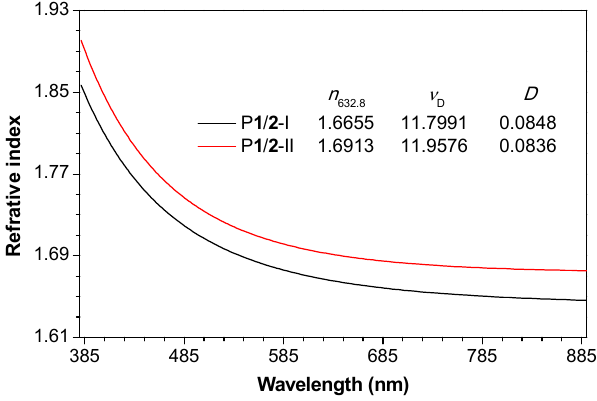
Figure 4. Wavelength dependence of refractive indices of thin films of P 1 / 2 -I and P 1 / 2 -II. Abbreviation: n = refractive index, ν D = Abbé number = ( n D − 1)/( n F − n C ), where n D , n F and n C are the RI values at wavelengths of 589.2, 486.1 and 656.3 nm, respectively, D = chromatic dispersion = 1/ ν D .